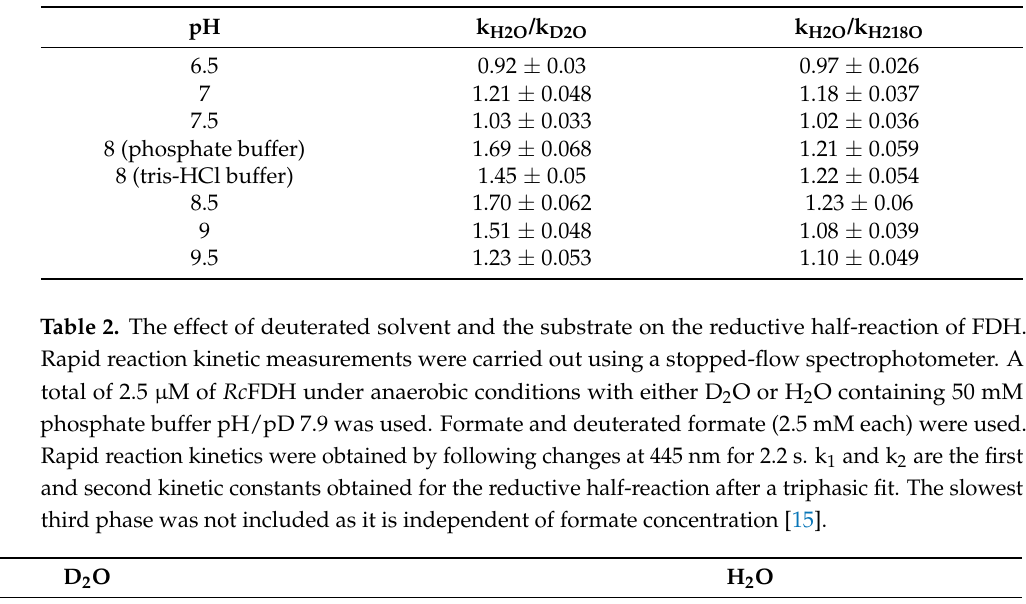
Table 1. Ratios of initial rate constants using unlabeled water versus 50% deuterium oxide (D 2 O) or